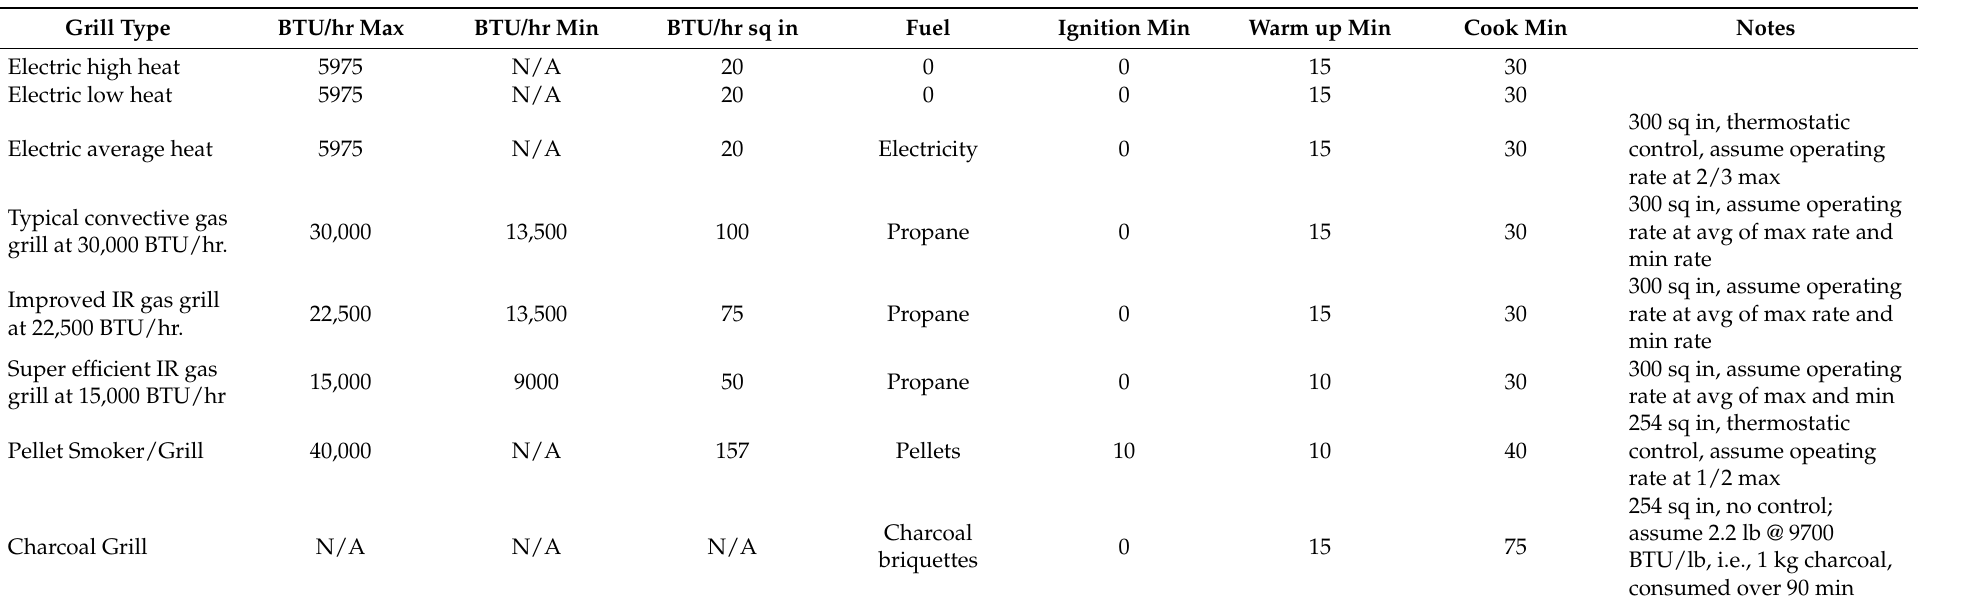
Table 5. Grill efficiencies and fire-up/cook